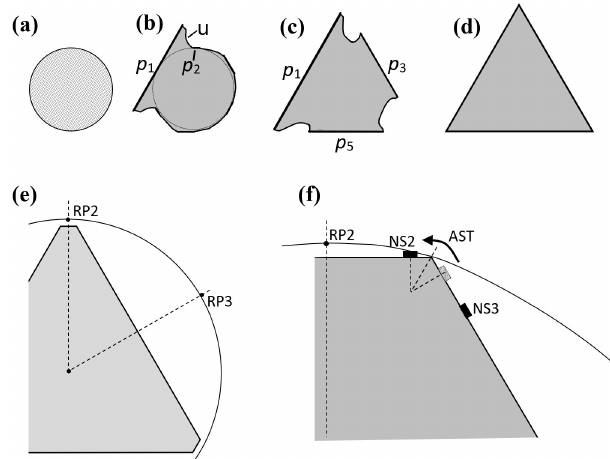
Figure B16. Formation and growth of a trigonal crystal. (a) Sub- micron droplet before freezing. (b) Upon freezing, prism face p 1 forms before the others, growing laterally via AST, stunting neigh- bors p 2 and p 6 . The region u may have a range of slopes, sometimes lining up along p 3 . (c) Prism face p 3 or p 5 develop next, also stunt- ing p 4 . (d) Trigonal forms. (e) Vapor-density contour around nearly trigonal form (scalene hexagonal) with small prism faces. RP2 and RP3 are points on p 2 and p 3 where a reflection-symmetry plane crosses the contour. (f) Corner region between prisms p 2 and p 3 . Solid boxes are the layer nucleation sites NS2 and NS3. Shaded box on p 3 to the left of NS3 is the nucleation site in the absence of